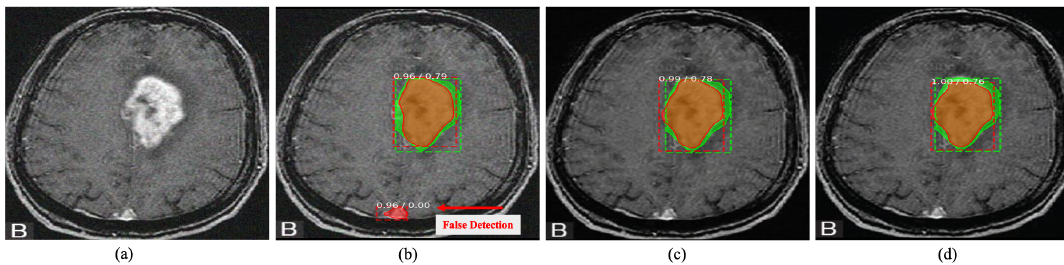
Figure 9. Tumour detection on brain MRI image. The green box indicates the ground truth region, while the red box indicates the detected area. The proposed DRAN can improve the localization performance of the detection method to localize the abnormalities by removing the noise present in the target image. ( a ) Noisy image. ( b ) Noisy image + Mask R-CNN [67]. ( c ) Denoised image obtained with DRAN + Mask R-CNN [67]. ( d ) Reference clean image + Mask R-CNN [67]. Source by: